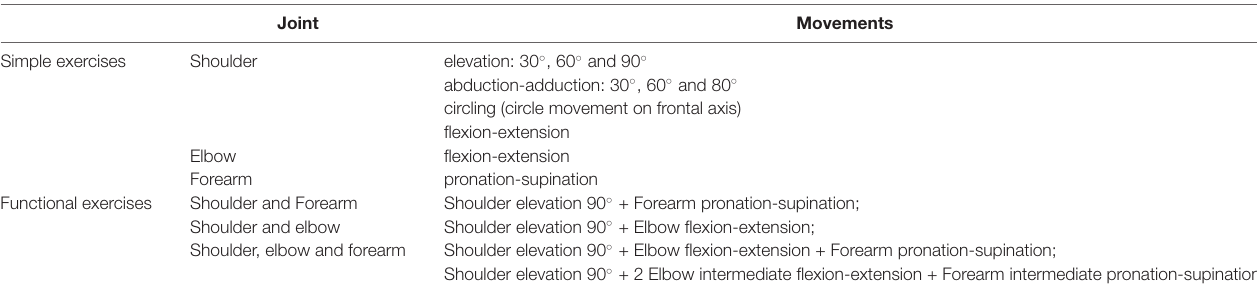
FIGURE 3 | Therapy protocol with ARAMIS.